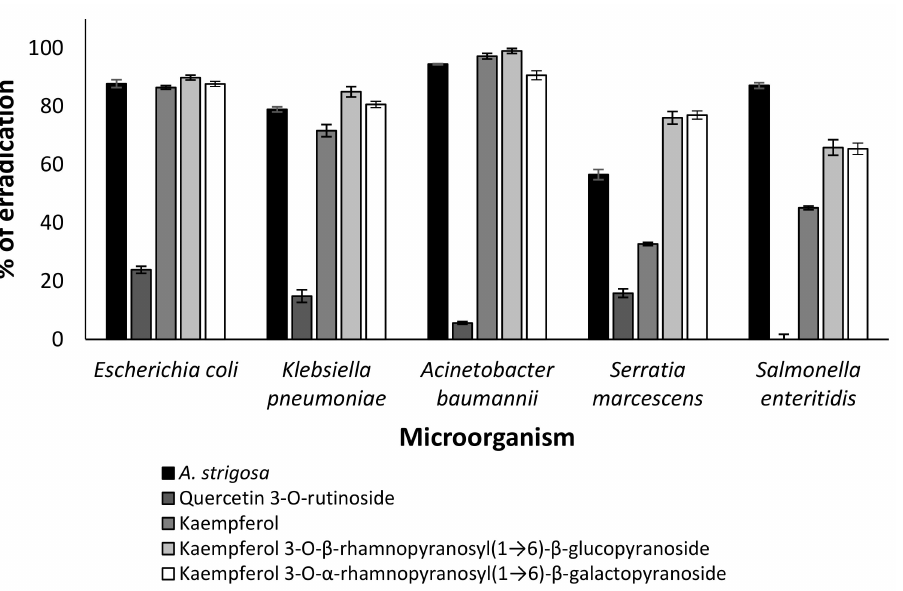
Figure 2. Effect of A. strigosa extract and its phytochemicals on eradication of drug-resistant mi- croorganisms ( Escherichia coli , Klebsiella pneumoniae , Acinetobacter baumannii , Serratia marcescens and Salmonella enteritidis ). The phytochemicals were applied at concentration of 2 µ M. Data from three independent experiments are